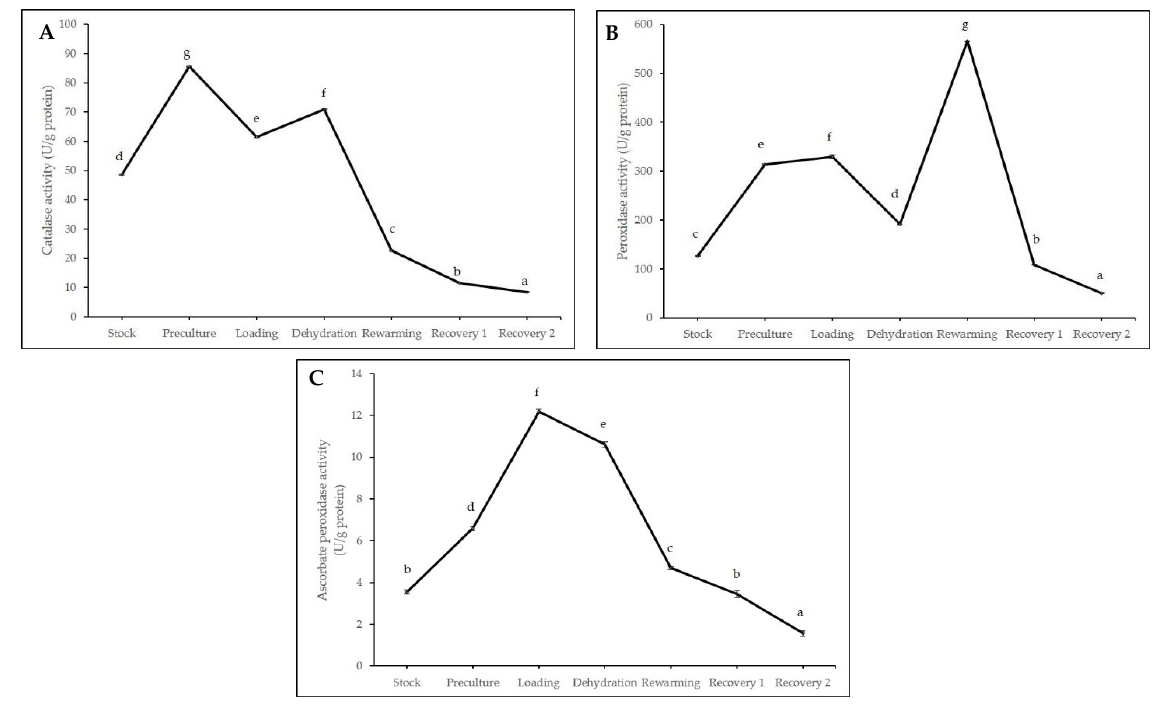
Figure 8. Antioxidant enzyme activities of ( A ) catalase; ( B ) peroxidase; and ( C ) ascorbate peroxidase of cryopreserved axillary buds at different stages in cryopreservation. Error bars represent standard errors. Means with different letters are significantly different based on Duncan Multiple Range Test (DMRT) at p ≤